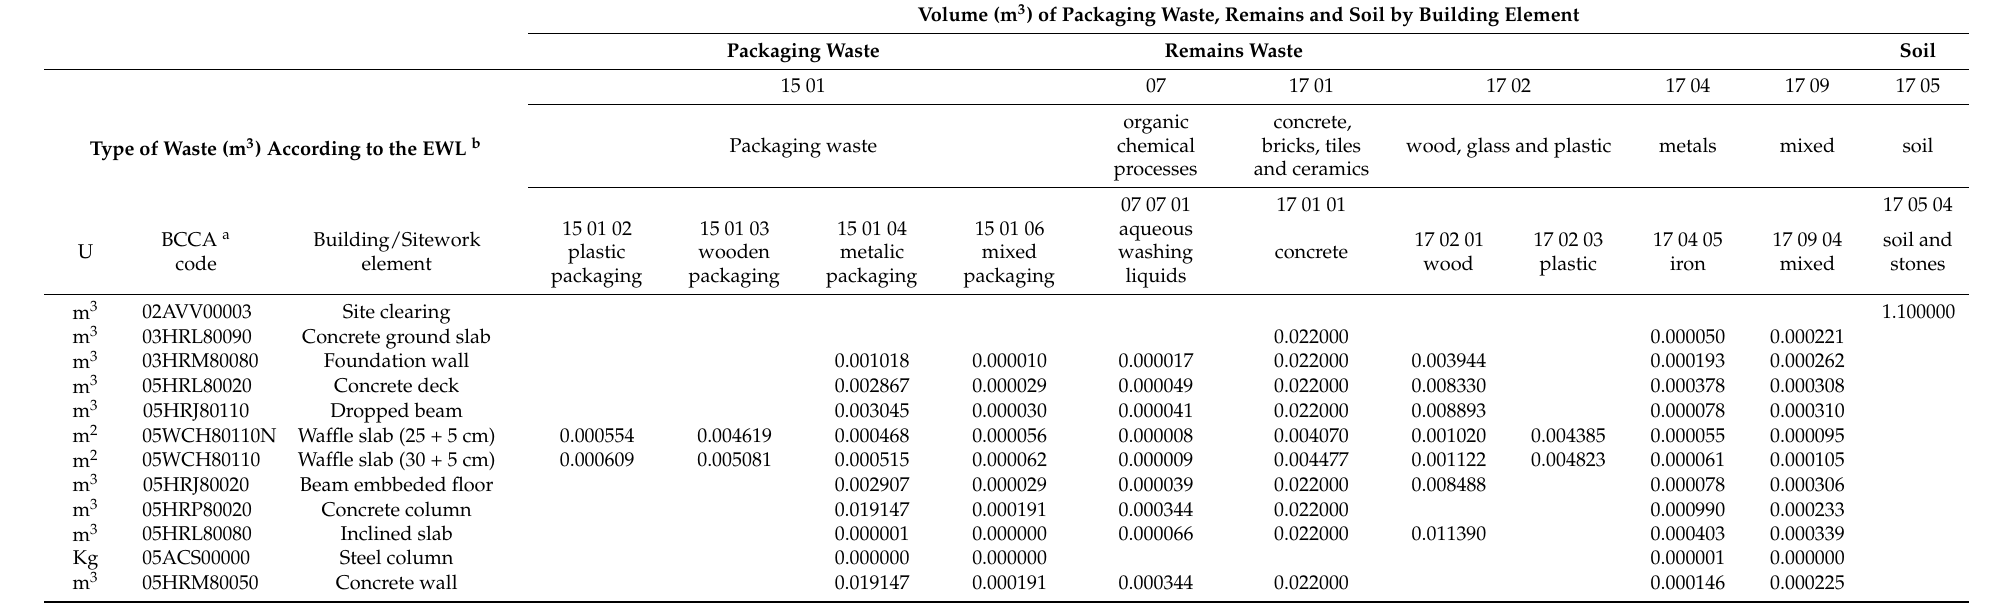
Table 2. CW expected in building elements. Data based on Llatas, 2011 [15] and Llatas and Osmani, 2016